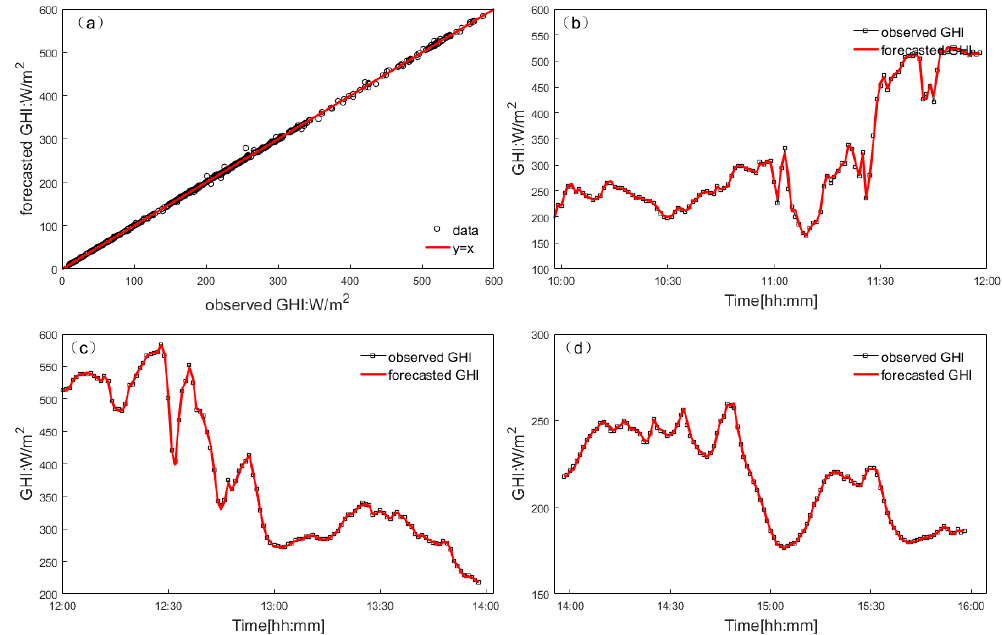
Figure 9. Nowcasting irradiance scatter plots on ( a ) 5 November 2017, ( b ) 10:00—12:00 on 5 November 2017, ( c ) 12:00—14:00 on 5 November 2017, ( d ) 14:00–16:00 on 5 November 2017.